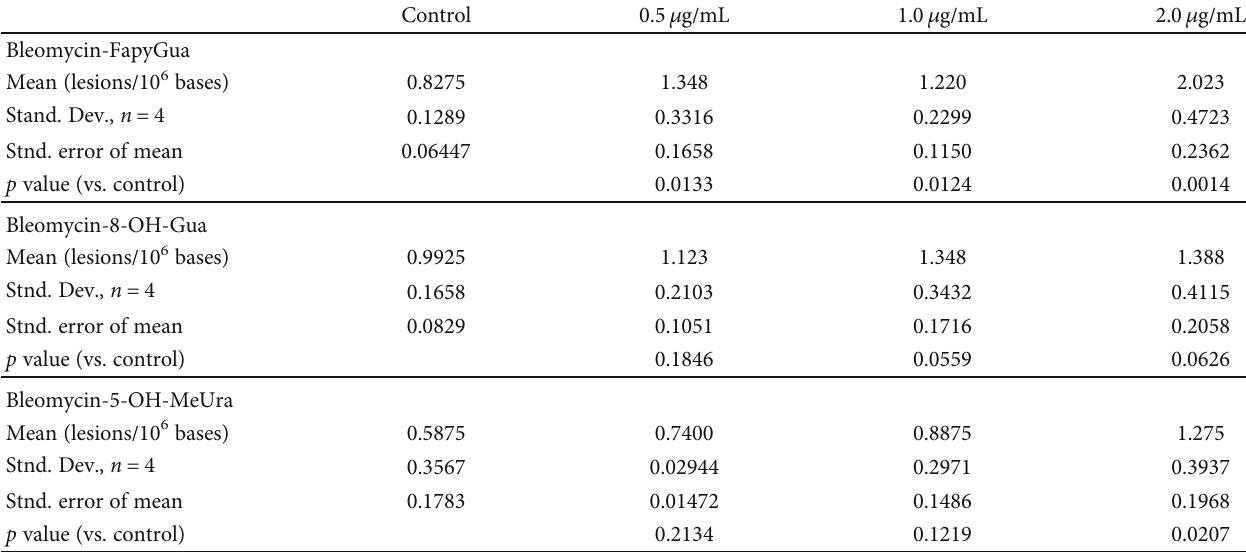
Table 2: Statistical analysis of GC-MS/MS data (base lesions/10 6 DNA